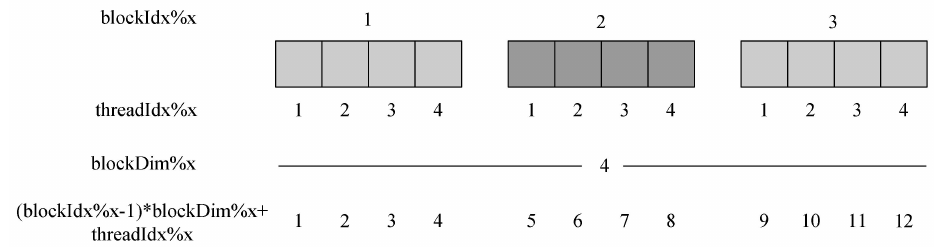
Figure 7. The indexing method of